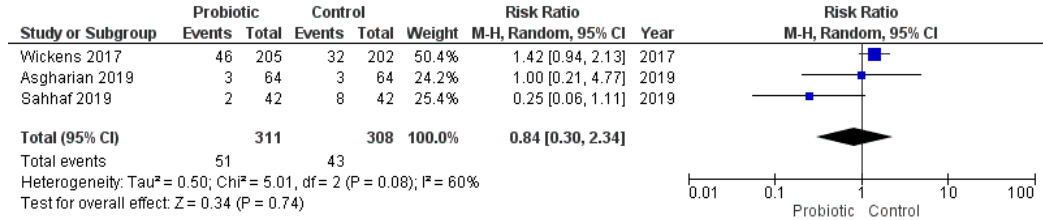
Figure 8. Meta-analysis of studies evaluating the administration of probiotic and macrosomia.